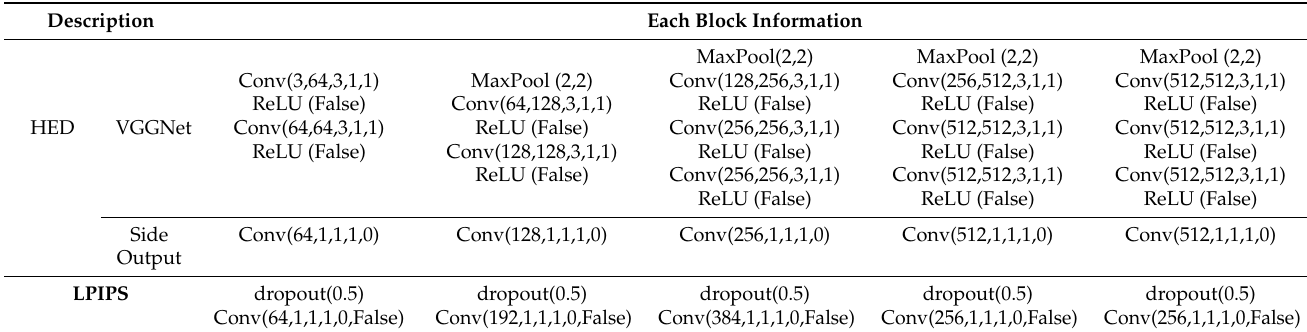
Table 2. The layers of RCCL